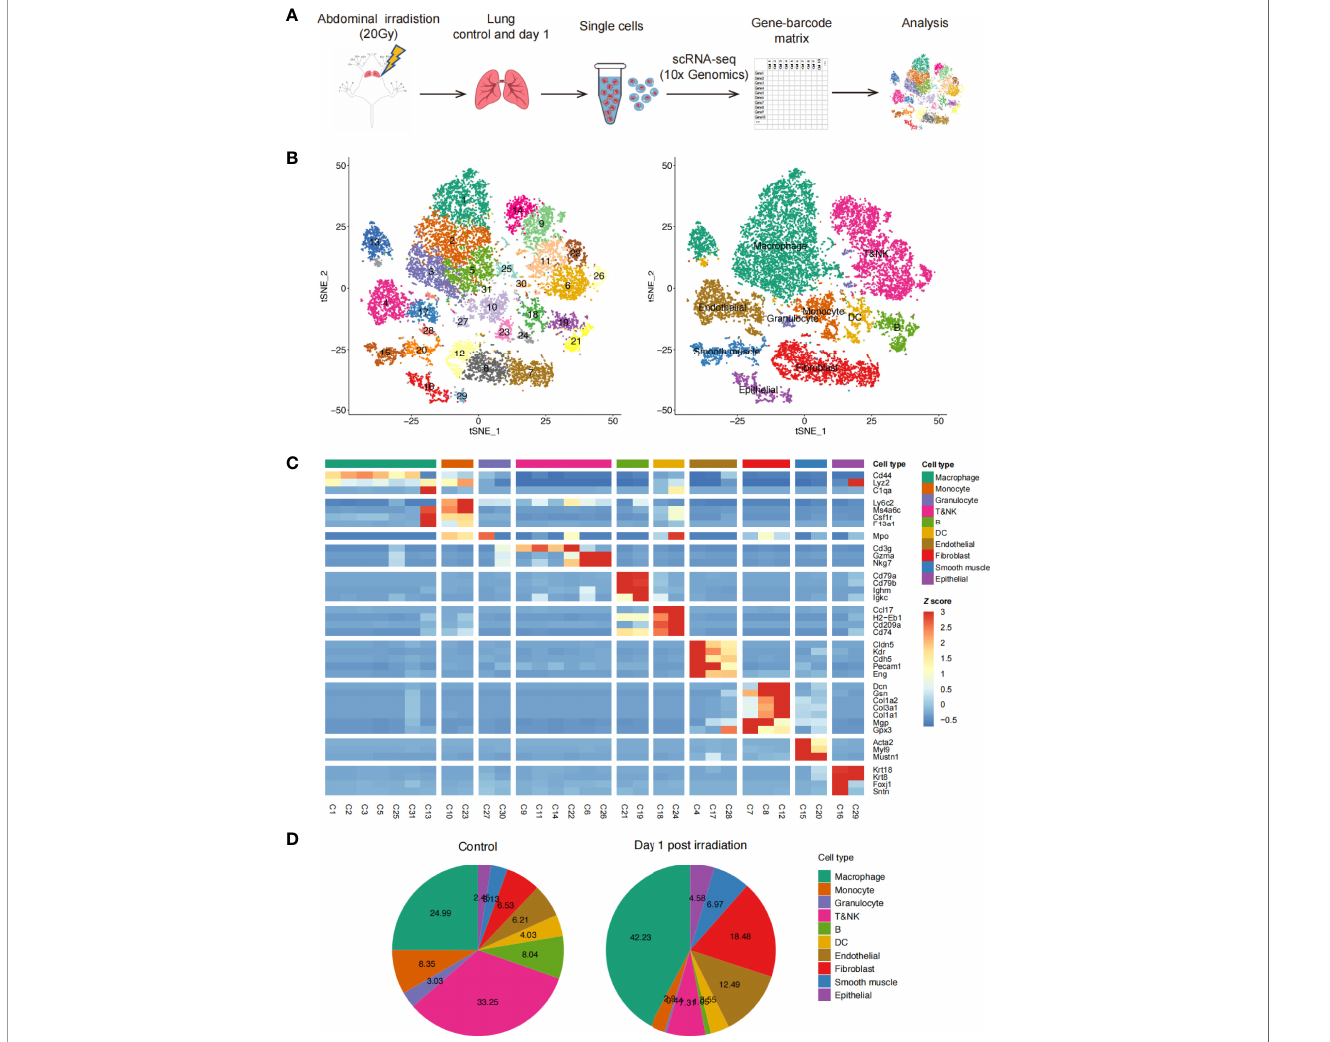
FIGURE 1 | Pro fi le of irradiation-induced lung injury (RILI) using scRNA-seq. (A) Schematic diagram of the experimental design and single-cell RNA sequencing (scRNA-seq) analysis. (B) t-SNE plot of 18,500 cells, color-coded by the associated clusters of Seurat cluster identities (left) and cell type annotations of samples (right). (C) Heatmap of cell type-speci fi c and classical marker genes across clusters, measured as the z-score normalized mean expression. (D) Pie charts of cell type fractions before and after radiation among all samples, colored by cell